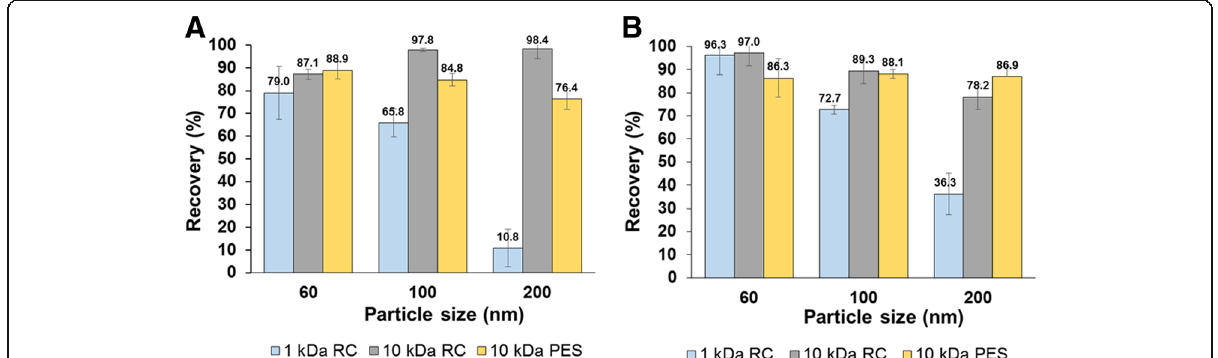
Fig. 4 Relative fractionation recovery of 60, 100, and 200 nm of silica nanoparticles obtained with the use of various membranes: 1 kDa RC (blue), 10 kDa RC and (gray), and PES 10 kDa (yellow) in different carrier solutions. a 0.02% FL-70 with 0.02% NaN 3. and b 0.25 mM ammonium carbonate